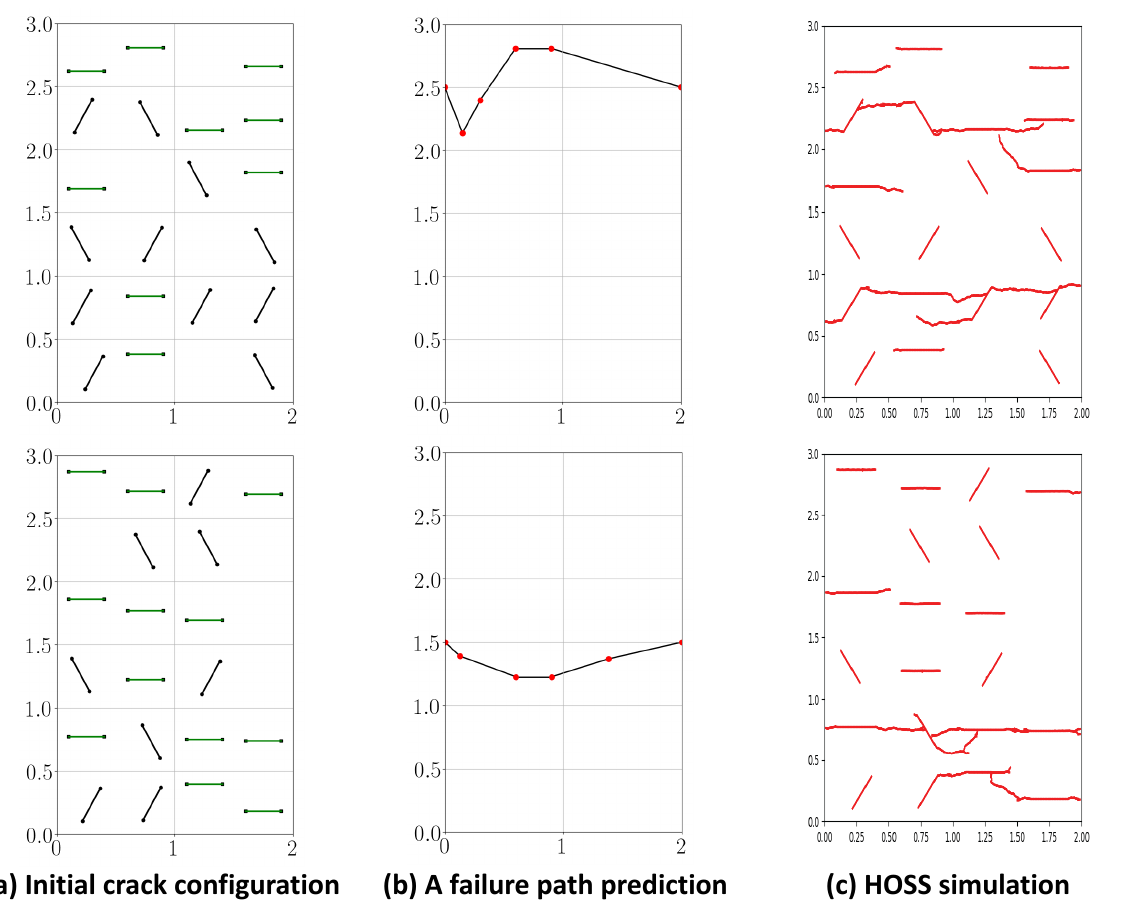
Figure 8. Failure path prediction (less than a 50% match): The above set of figures show the scenarios where the proposed method failed to predict the HOSS results.